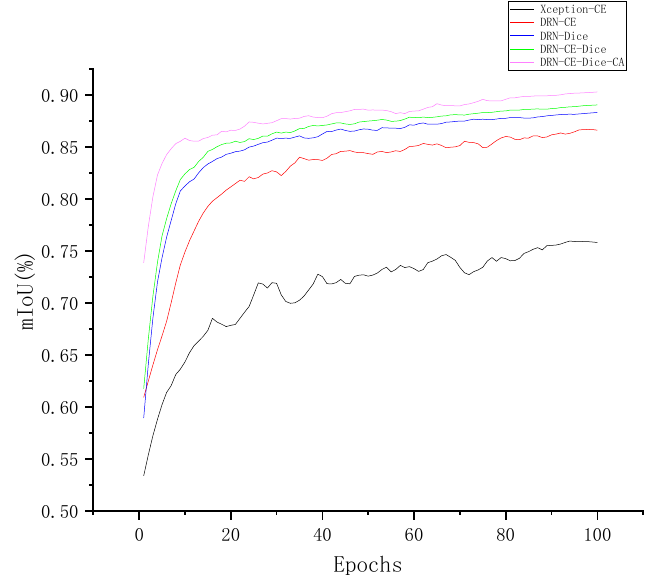
Figure 5. A comparison of the mIoU curves for transfer learning.